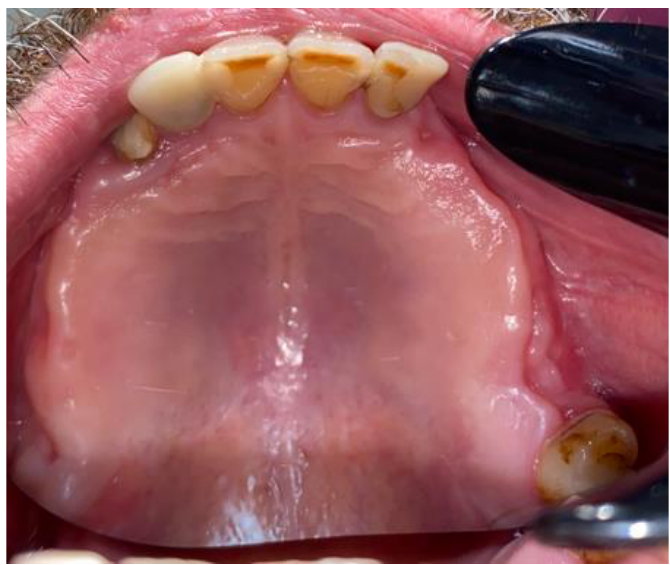
Figure 5. Intraoral photograph with granulation tissues arising from under the dental bridge.